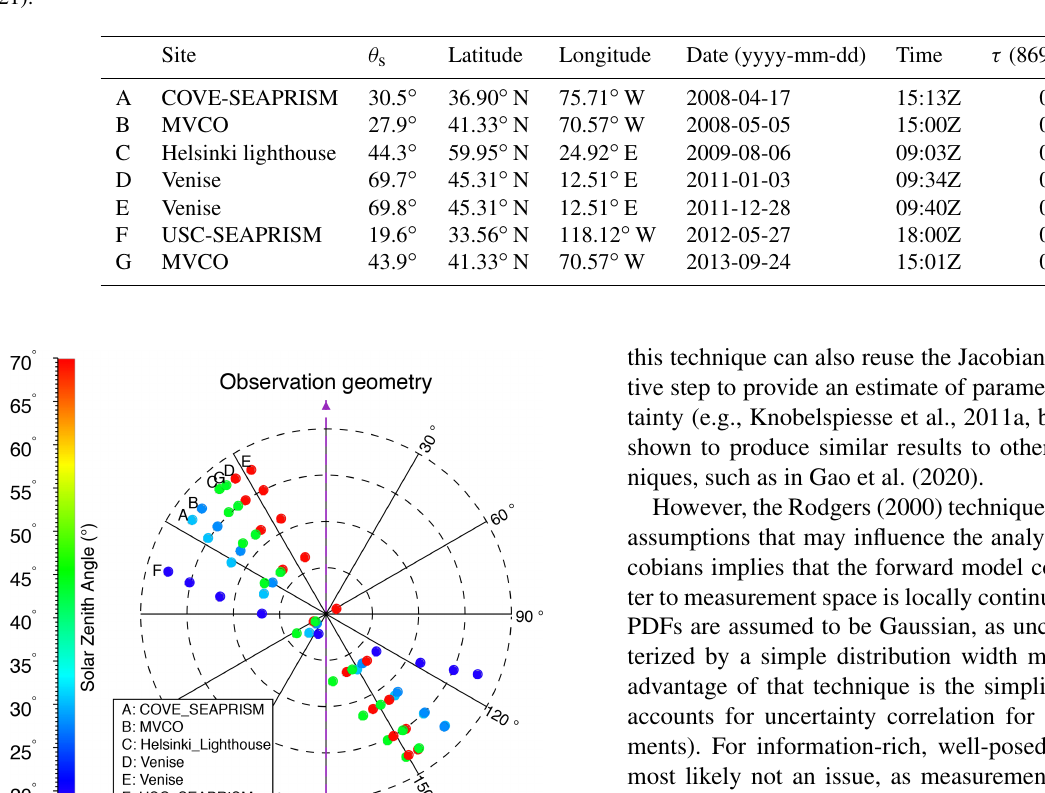
Table 4. Location and time of selected AERONET-OC sites with coincident MISR observations. The solar and observation geometries of these sites were used in our ICA. More details on the individual sites can be found at https://aeronet.gsfc.nasa.gov/ (last access: 30 April 2021).